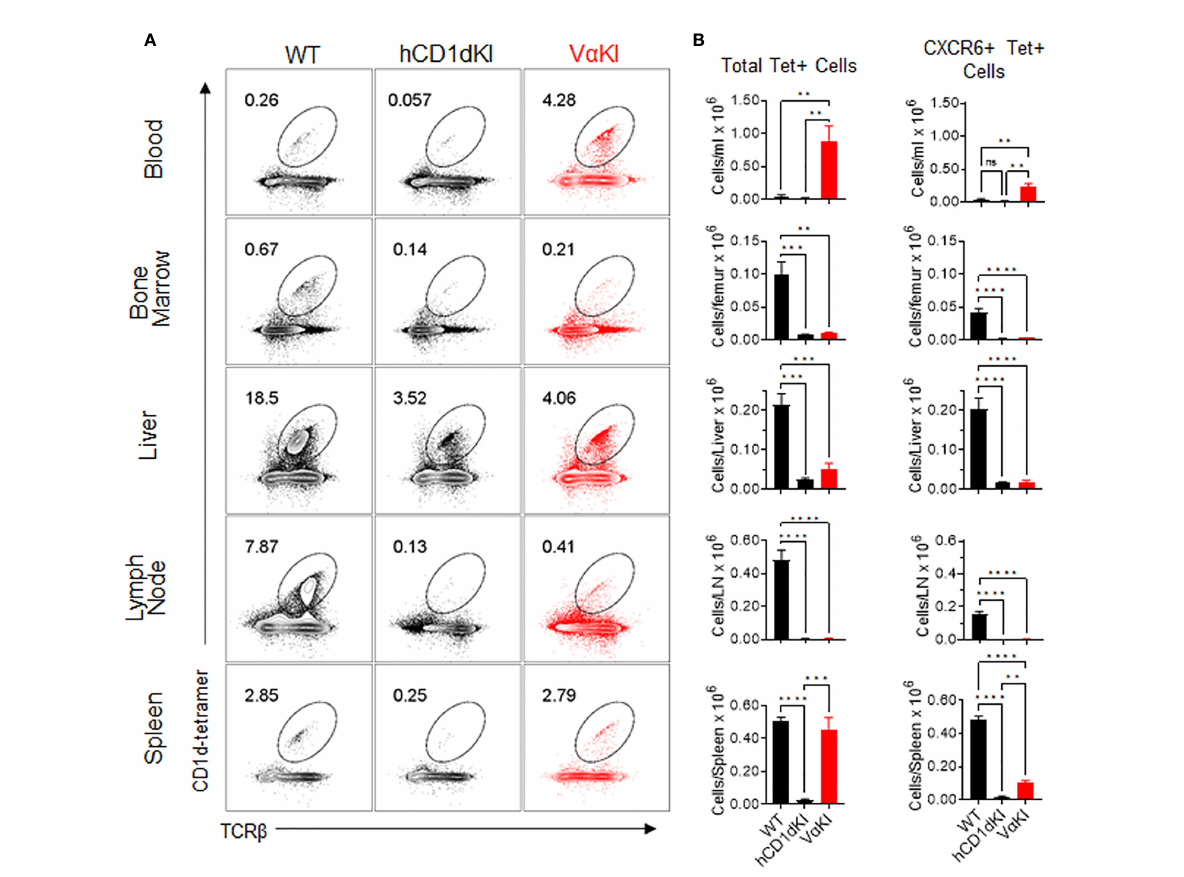
FIGURE 6 Frequency and numbers of iNKT cells in blood and various tissues of V a KI mice. (A) Representative dot plots from FACS analysis for CD1d-Tet and TCR b staining of B220 negative live lymphocytes from each of the indicated tissues of WT (C57BL/6), hCD1dKI or V a KI mice. Lymph nodes were mesenteric nodes, and bone marrow was obtained from femurs. Numbers within the plots are the percentages of B220 negative live lymphocytes in the regions demarcated as ovals. (B) Bar graphs summarizing FACS results as in A for groups of 4 mice for each mouse strain. Absolute cell numbers were calculated based on total cell yields from each tissue, and bars show means ± 1SE. **P < 0.01, ***P < 0.001, ****P < 0.0001; ns, not signi fi cant (one-way ANOVA with Tukey